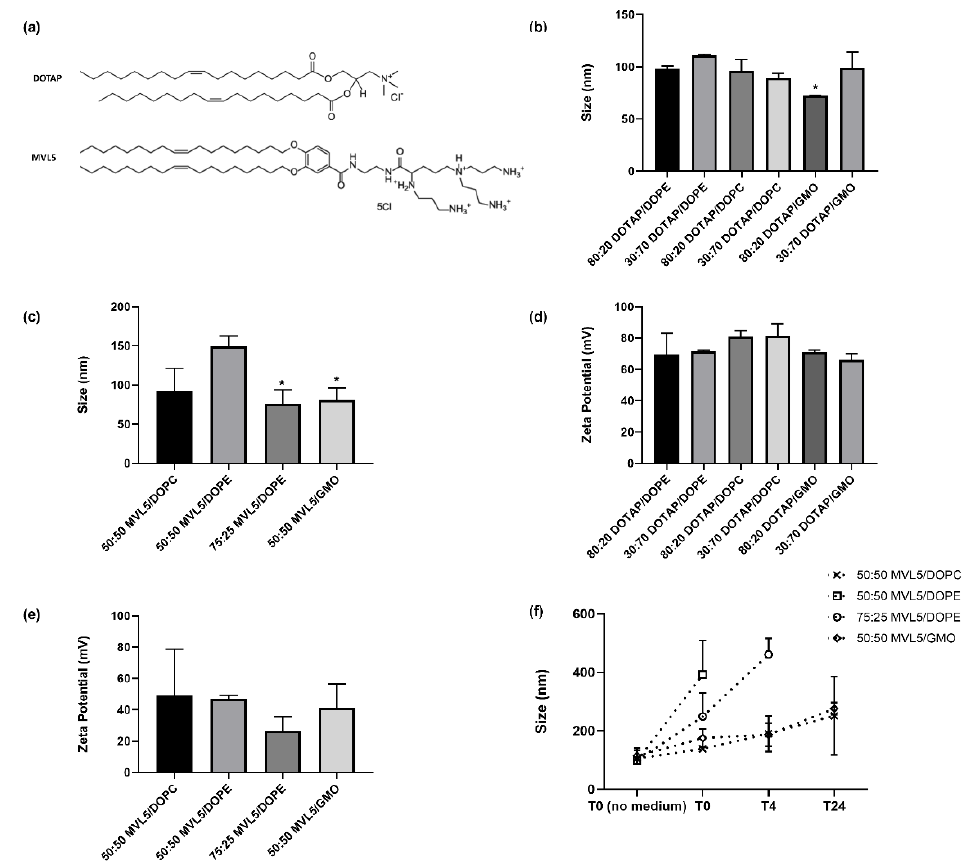
Figure 2. Chemical structure of monovalent cationic lipid DOTAP and multivalent cationic lipid MVL5 ( a ). Biophysical characterization of monovalent (DOTAP), and multivalent (MVL5) lipoplexes incorporating the PX458 plasmid at CR (+/ − ) 3 ( b – d ) and CR (+/ − ) 10 ( e ). The average size and zeta potential of DOTAP and MVL5-based lipoplexes were measured in ultrapure nuclease-free Milli-Q water. Data represent at least three independent experiments and are presented as the mean ± SD. Formulations marked with an asterisk showed bimodal distributions fitted with a biexponential decay model. ( f ) DLS measurements of the hydrodynamic diameter of the MVL5-based lipoplexes incubated with DMEM at 37 ◦ C. Formulations marked with “*” were fitted with a biexponential decay model.